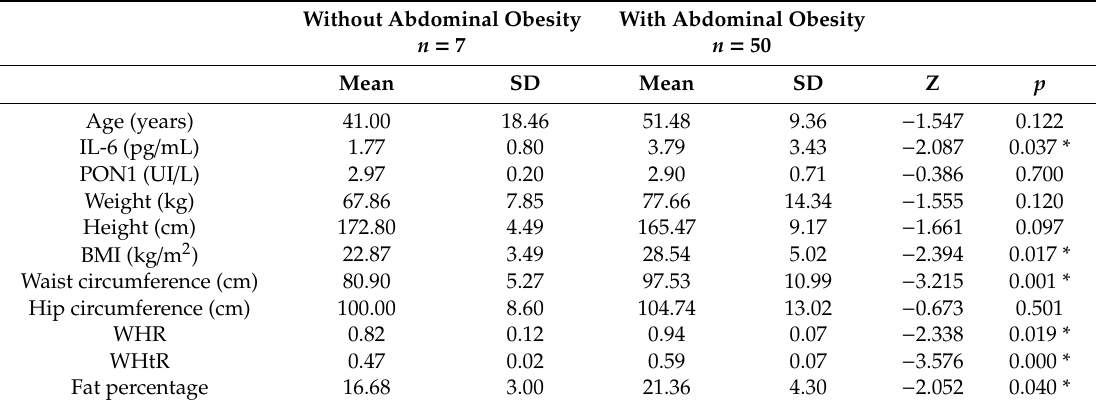
Table 3. Comparison between patients with or without abdominal obesity, according to waist-to-height ratio (WHtR).